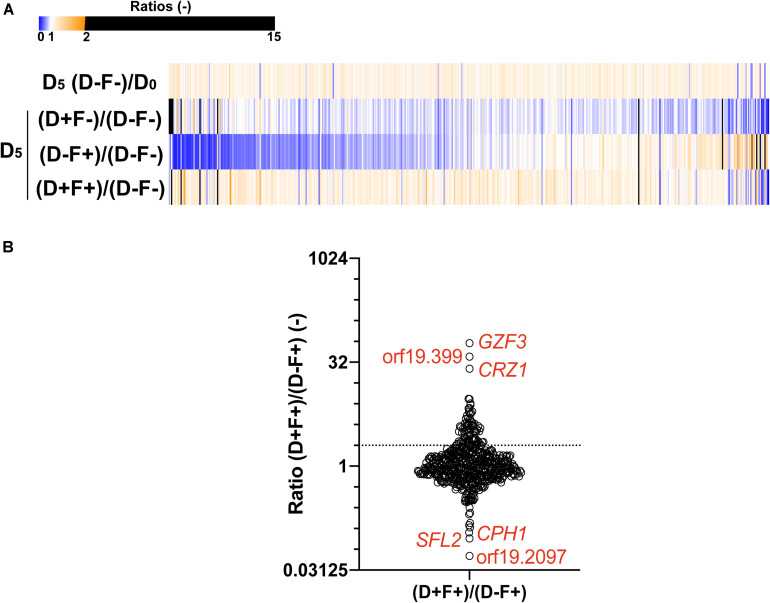
Comparisons of the population of the 572-Tet-inducible OE strains collection pool after 5 days of enrichment. (A) The heatmap represents the comparison between the cultures at day 5 (D5) and the initial population (D0), in presence (F+) or absence (F–) of FLC (32 μg/ml), and in the presence (D+) or absence (D–) of 100 μg/ml Dox. Each line represents the mean relative count ratio of biological duplicates. The heatmap is filtered based on the [D5 (D+F+)/D5 (D–F+)] comparison. (B) Enrichment of specific Tet-dependent OE strains in the presence of FLC with and without Dox. The dotted line represents a 2-fold threshold enrichment between FLC exposed cells in the absence and presence of Dox. Y-axis is in log2 scale. Detailed data can be found in Supplementary File S2.